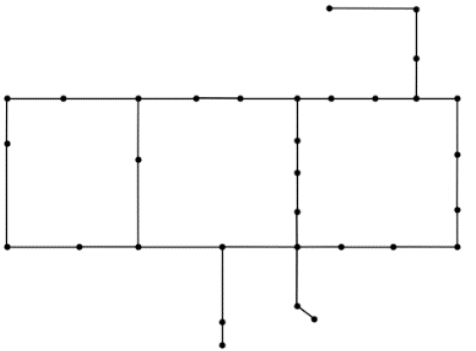
Figure 12. A schematic representation of the Hanoi water distribution network.